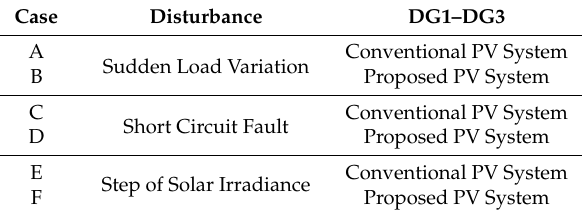
Table 2. Cases Description.